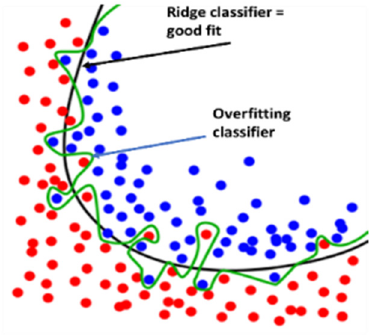
Figure 11. Heuristic view of ridge classifier vs. an overfitting classifier. The diagram fits any none-over-fit classifier.